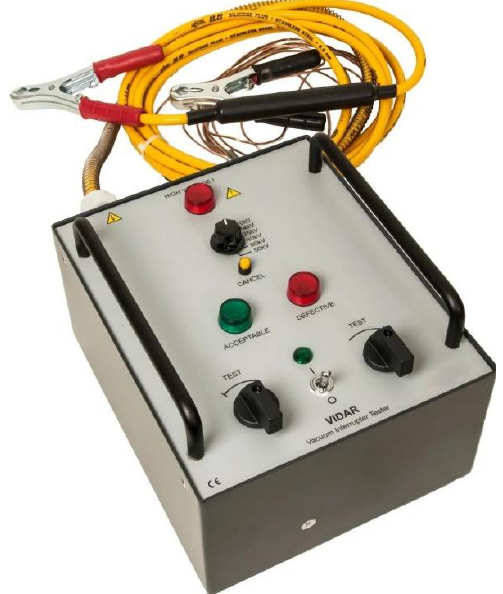
Figure 5. Vacuum chamber tester Vidar [57].